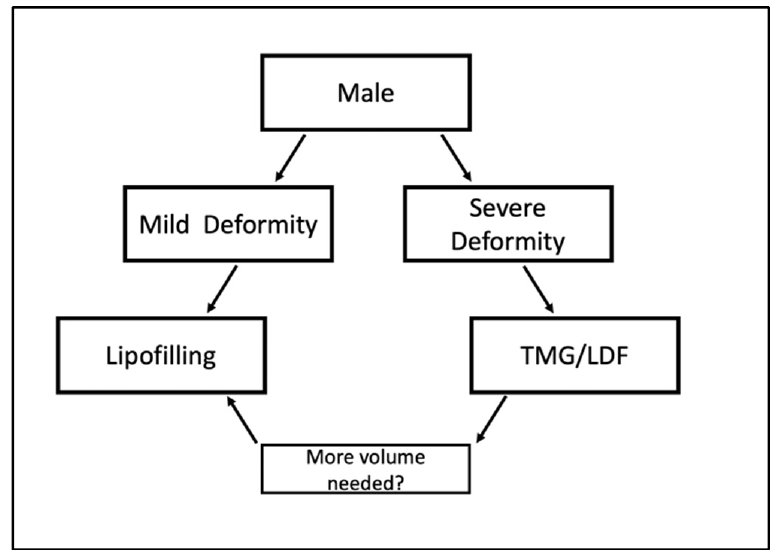
Figure 7. Algorithm for treatment of male patients. J. Clin. Med. 2021 , 10 , x FOR PEER REVIEW